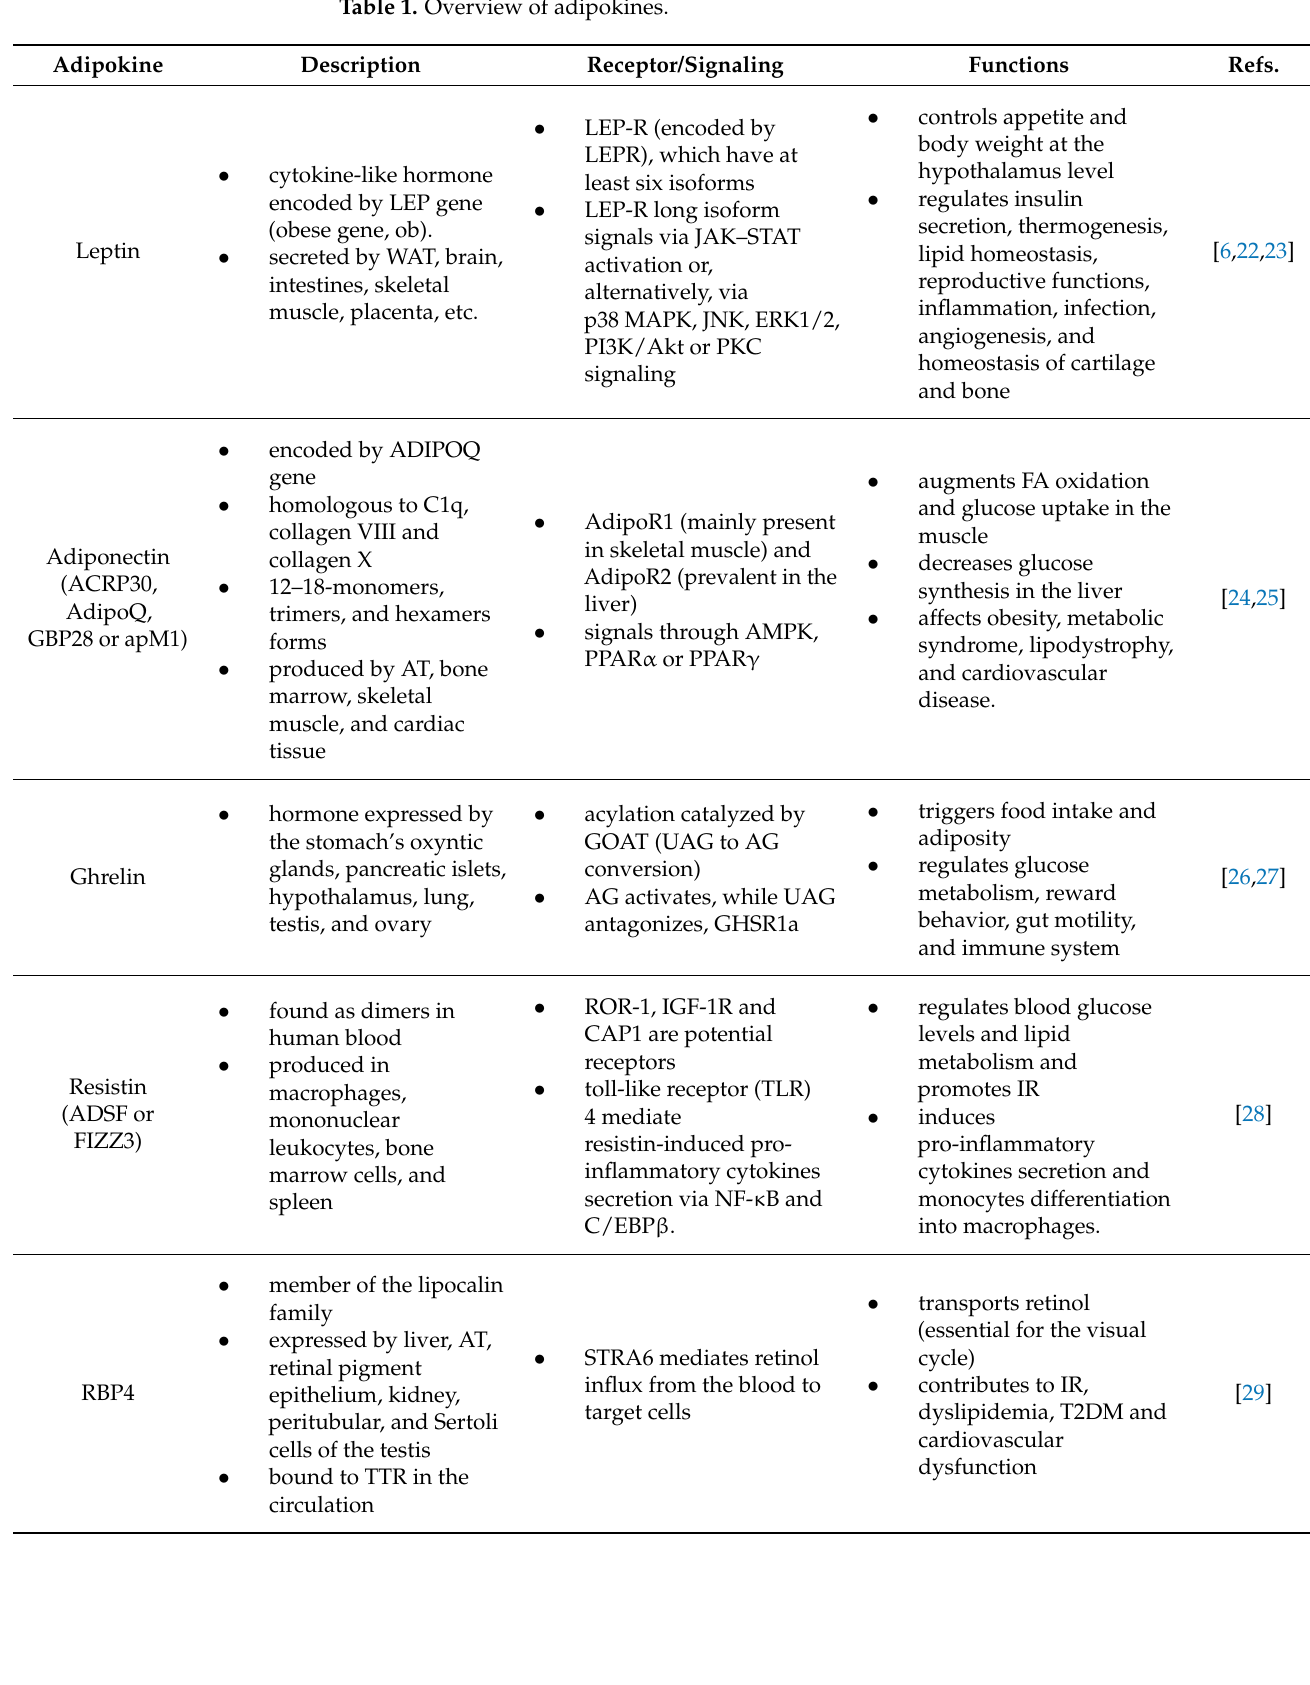
Table 1. Overview of